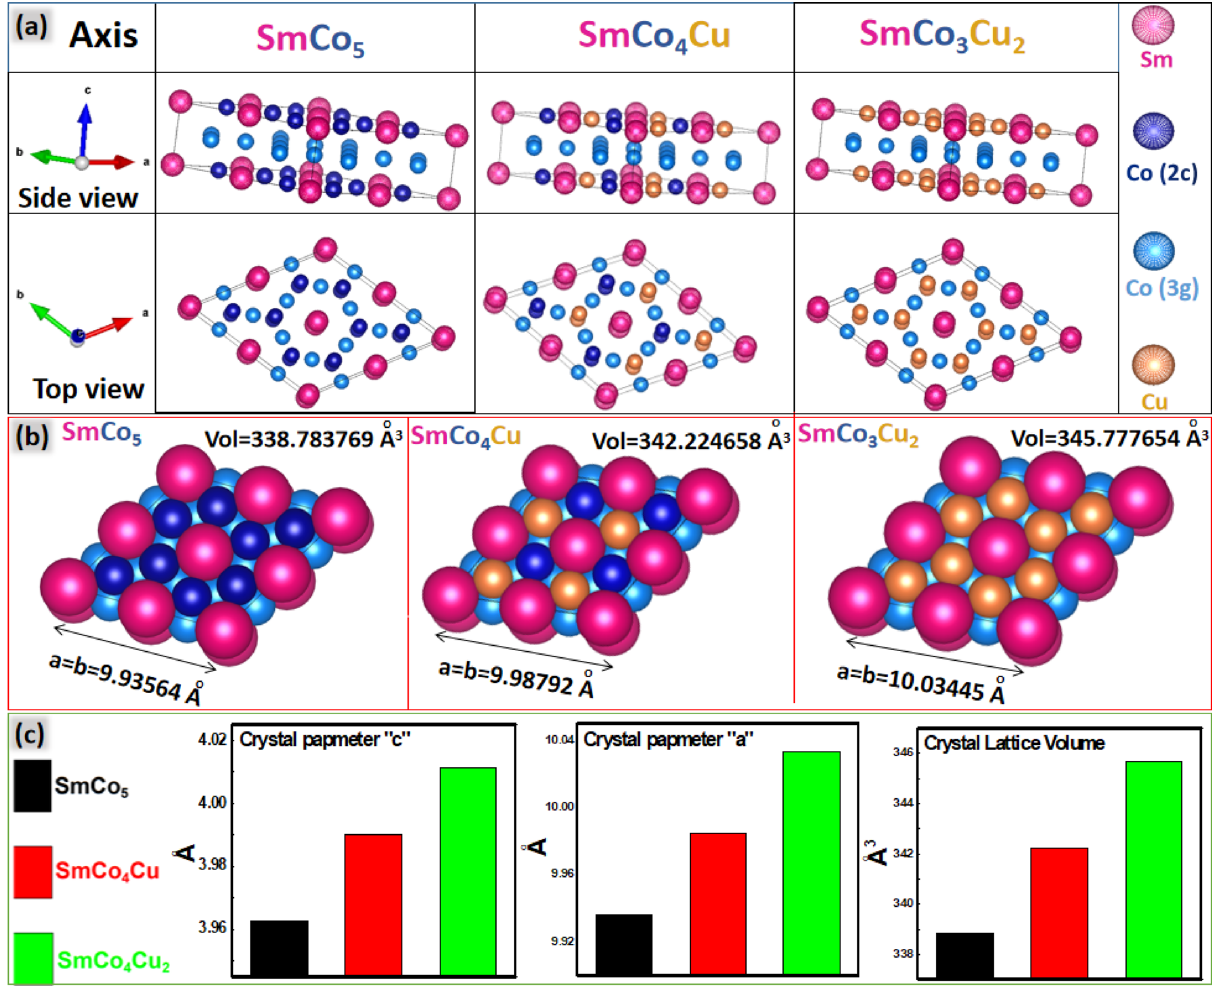
Figure 4. ( a ) Top and side view of arrangement of the atoms in SmCo 5 and SmCo 5−x Cu x , ( b ) space-filling model of SmCo 5 and SmCo 5−x Cu x with crystal dimensions, ( c ) crystal parameters of SmCo 5 and SmCo 5−x Cu x